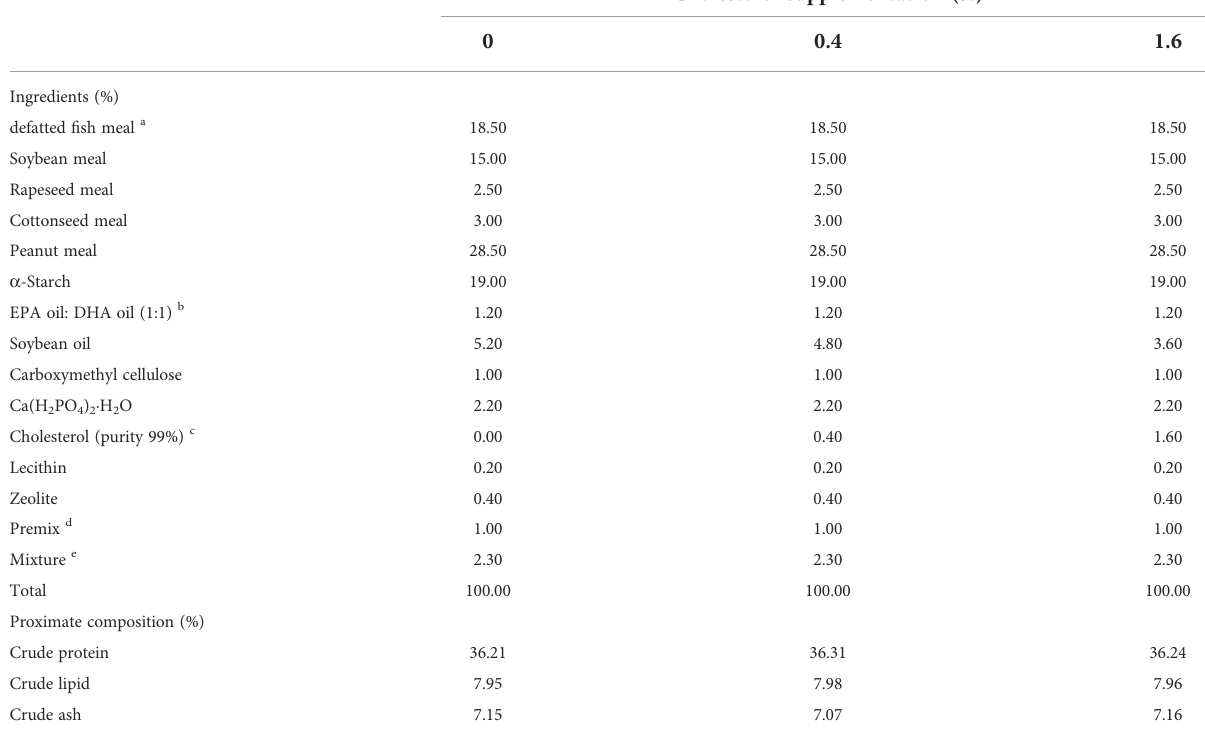
TABLE 1 Ingredient formulation and proximate composition (% dry matter) of the diet in this feeding